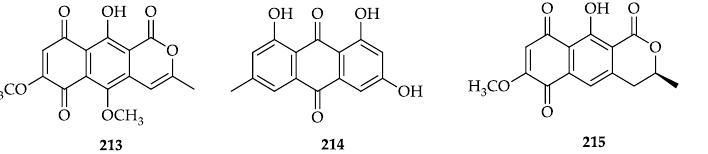
Table 7. Quinones isolated from Eriocaulaceae species. Compounds